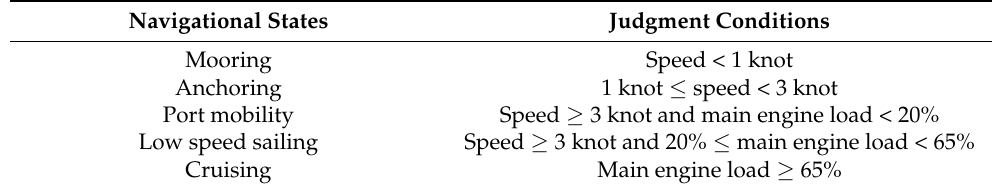
Table 1. Basis of the determination of vessel navigation